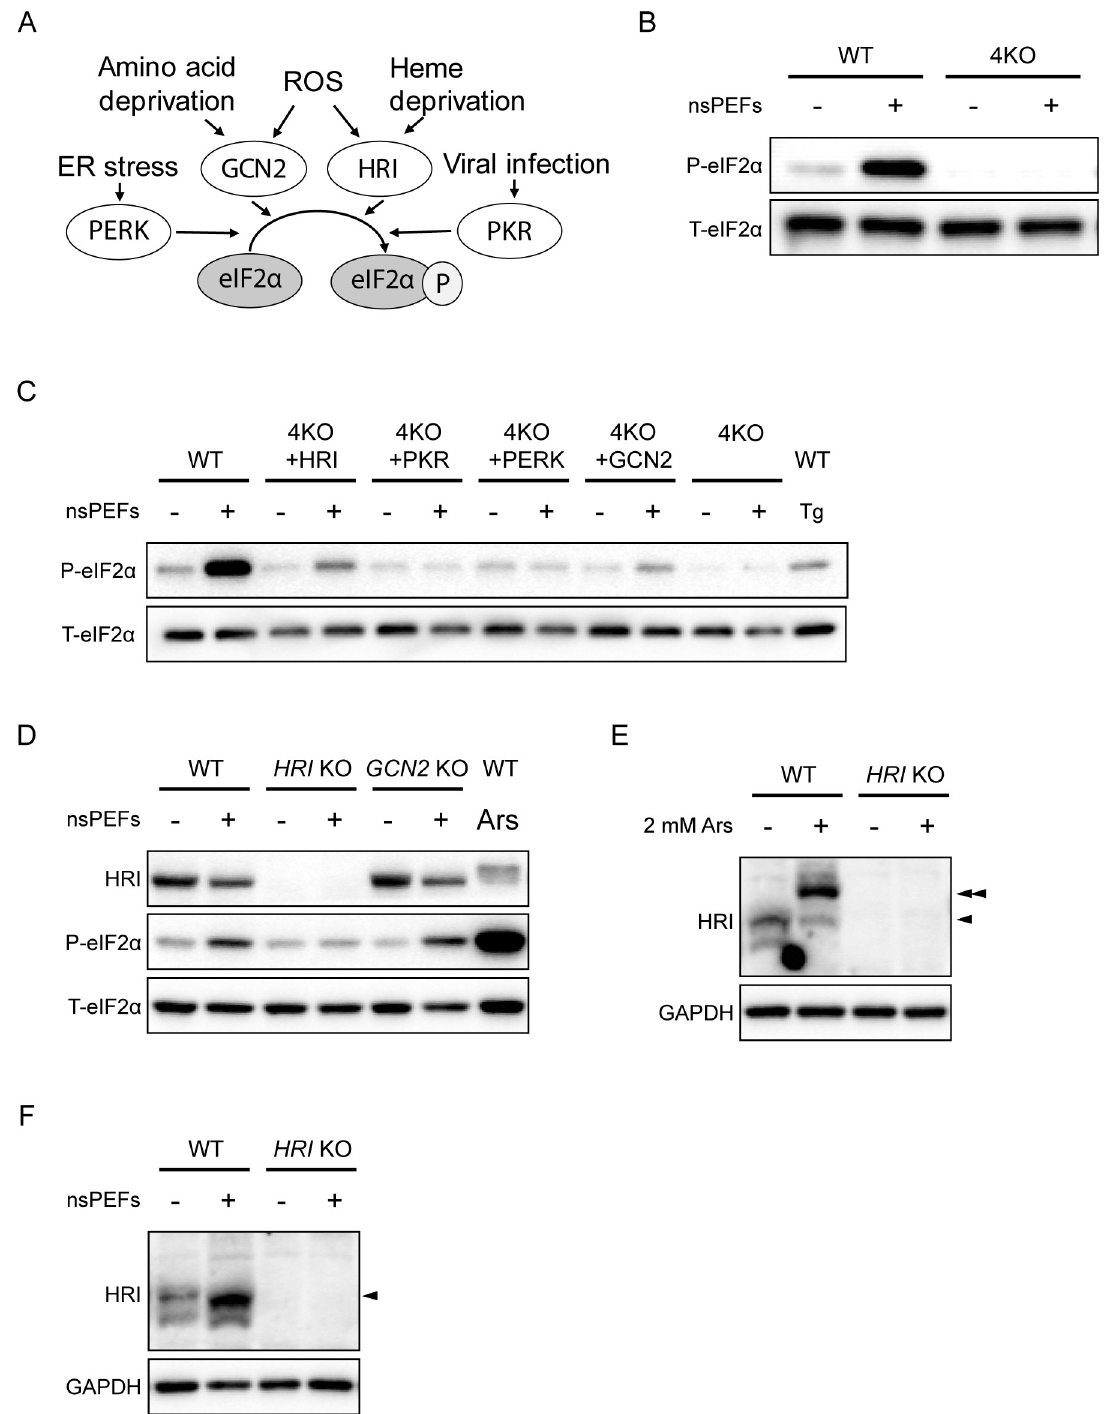
Fig 2. The eIF2 α kinase HRI is responsible for nsPEF-induced eIF2 α phosphorylation. ( A ) Various stressors phosphorylate eIF2 α via activation of four eIF2 α kinases, PERK, GCN2, HRI and PKR. ( B ) Representative immunoblots of phosphorylated eIF2 α and total eIF2 α in WT and 4KO MEF cells 1 h after nsPEF treatment (40 shots of 70-ns duration and 30-kV/cm electric fields). ( C ) Representative immunoblots of phosphorylated eIF2 α and total eIF2 α in WT, 4KO and single eIF2 α kinase-rescued 4KO MEF cells 1 h after nsPEF treatment (40 shots of 70-ns duration and 30-kV/cm electric fields). Treatment with 200 nM Tg served as a positive control for eIF2 α phosphorylation. (D) Representative immunoblots of HRI, phosphorylated eIF2 α and total eIF2 α in WT HRI KO and GCN2 KO Hap1 cells 1 h after nsPEF treatment (40 shots of 70-ns duration and 30-kV/cm electric fields). nsPEFs induced eIF2 α phosphorylation in WT